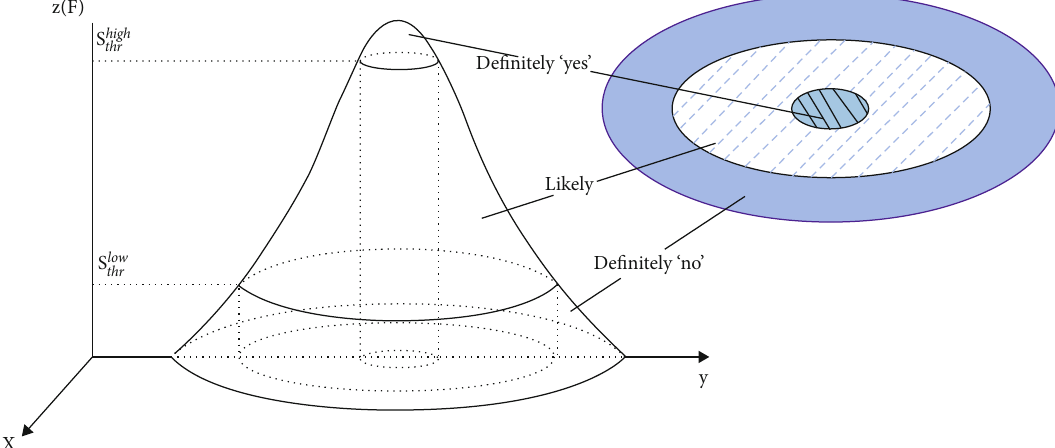
Figure 2: A typical plot representing values of the position-dependent parameter S in the vicinity of the target object — a “ cone ” shape re fl ects the impact of the object on the parameter that will be measured by ground sensors. The three sections (de fi nitely “ yes, ” likely, and de fi nitely “ yes ” ) literally express how possibly the object is really located